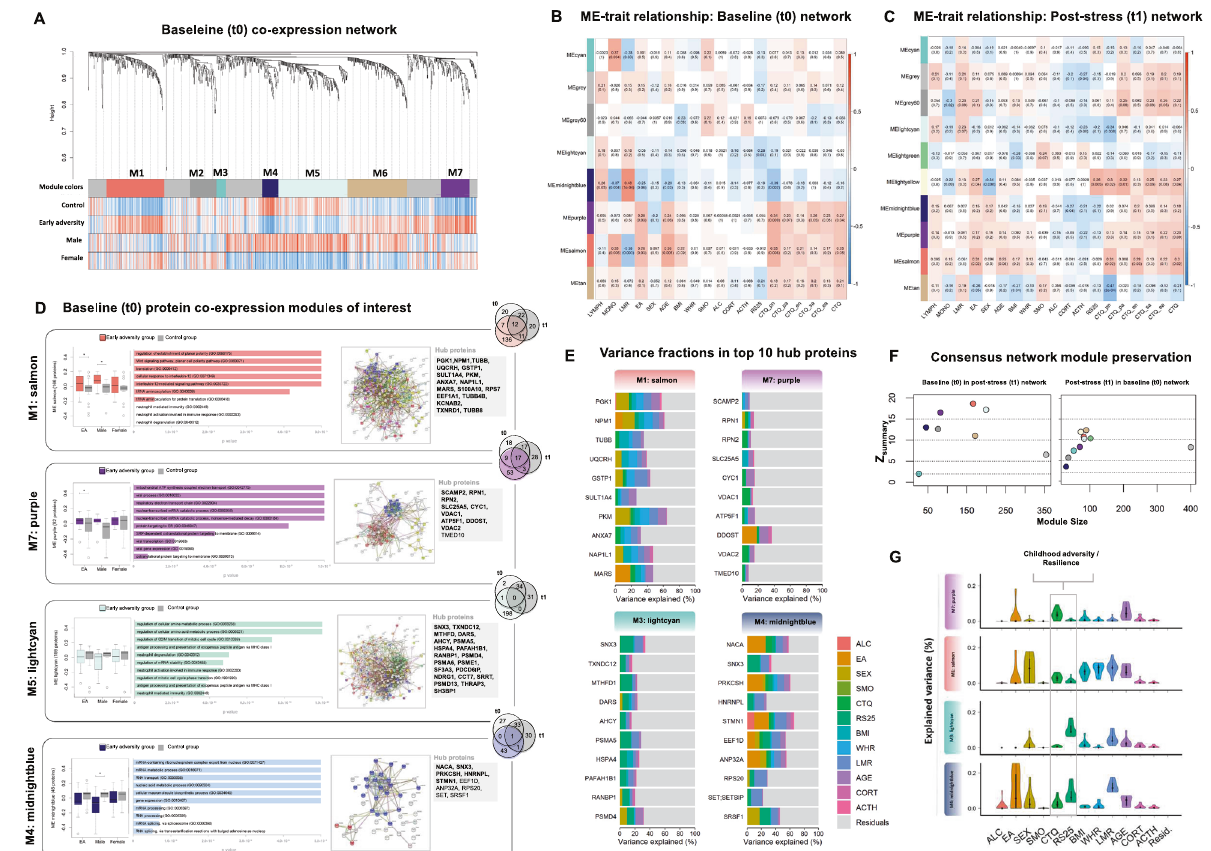
Fig. 4 Consensus protein co-expression network analysis. Dendrogram ( A ) of the consensus baseline proteome comprising the 1119 proteins that represent the intersection of proteins identi fi ed at the t0 baseline measurement and the t1 post-stress measurement. Each line represents a protein (leaf) and each low-hanging cluster represents a group of proteins with similar network connections (branch) on the tree. The fi rst band underneath the tree indicates the seven detected modules and subsequent bands indicate protein-trait correlation. Red indicates a strong positive relationship and blue indicates a strong negative relationship. Module eigenprotein (ME) correlation with clinical variables are depicted for modules derived from co-expression networks built upon baseline (t0) and post-stress (t1) measurements of the consensus proteome ( n prot = 1119) ( B , C : LYMPH & MONO = count of lymphocytes and monocytes, LMR = lymphocyte to monocyte ratio, EA = early adversity group, SEX = biological sex, AGE = age in years at participation, BMI = body mass index, WHR = waist to hip ratio, SMO = smoking, ALC = consumption of alcohol, CORT & ACTH = Cortisol and ACTH base to peak ratio, RS25 = Resilience Scale 25 total score, CTQ_pn = CTQ physical neglect score, CTQ_pa = CTQ physical abuse score, CTQ_en = CTQ emotional neglect score, CTQ_sa = CTQ sexual abuse score, CTQ_ea = CTQ emotional abuse score, CTQ = Childhood trauma questionnaire total score). D the associations between ME values and early adversity (coloured boxplots) and control group (grey boxplots) are shown strati fi ed by sex (*indicates p < 0.05; please note that p values did not survive correction for multiple testing). For each module, the 10 most signi fi cantly enriched biological processes are reported and ranked by -log10 p values). Venn Diagrams indicate the overlap of baseline module proteins and DEP a identi fi ed at t0 and t1. String networks were generated for each of the presented modules. Protein colors indicate functional or topological associations within the salmon module (red: mitochondrion, blue: translation, yellow: immune response, pink: viral processes), the purple module (red: ATP metabolic processes, blue: translational initiation, yellow: immune response), the light cyan module (red: vesicle-mediated transport, yellow: immune system processes, blue: viral processes, green: mRNA splicing) and the midnight blue module (red: aerobic respiration, blue: gene expression). High-resolution STRING network illustrations for modules of interest and details about all other modules are provided in the SI. Preservation ( Z summary ) of baseline (t0) consensus modules in the post-stress (t1) consensus network and vice versa is depicted by plotting the module- speci fi c Z summary score against the module size ( F ). We report the top 10 and top 10 percent (bold) of the module-associated hub proteins in grey boxes. Bar plots ( E ) represent partitions of variance explained by a set of variables within the top 10 hub proteins of M1, M7, M4, and M3. Violin plots represent the overall distribution of variance explained by each variable within the top ten module-speci fi c hub proteins. Note that residuals are not plotted ( G Three of the DEP a identi fi ed before and after stress exposure Next, we analyzed to what extent proteins of conserved baseline and post-stress co-expression networks overlapped were part of the midnight blue or the light cyan module and with the DEP a identi fi ed using limma analysis and paid particular none of these proteins represented a hub protein. The salmon module on the other hand comprised altogether 30 DEP a . attention to hub proteins. Hub proteins are part of highly correlated protein assemblies in modules and are likely Among these, S100A11, a calcium-binding protein, is mechan- important from a co-expression perspective. We focused our istically involved in toll-like receptor-mediated in fl ammatory analysis on the four most conserved modules indicating responses of macrophages [46]. Interestingly, 41% of the salmon differential activities between groups and report both, top ten modules hub proteins were differentially expressed between and top ten percent of proteins with the highest kME values for groups (TUBB, SULT1A4, TXNRD1, NAP1L1, RPS7, NPM1, and each module in Fig. 4. KCNAB2). The purple module includes altogether 29 DEP a of